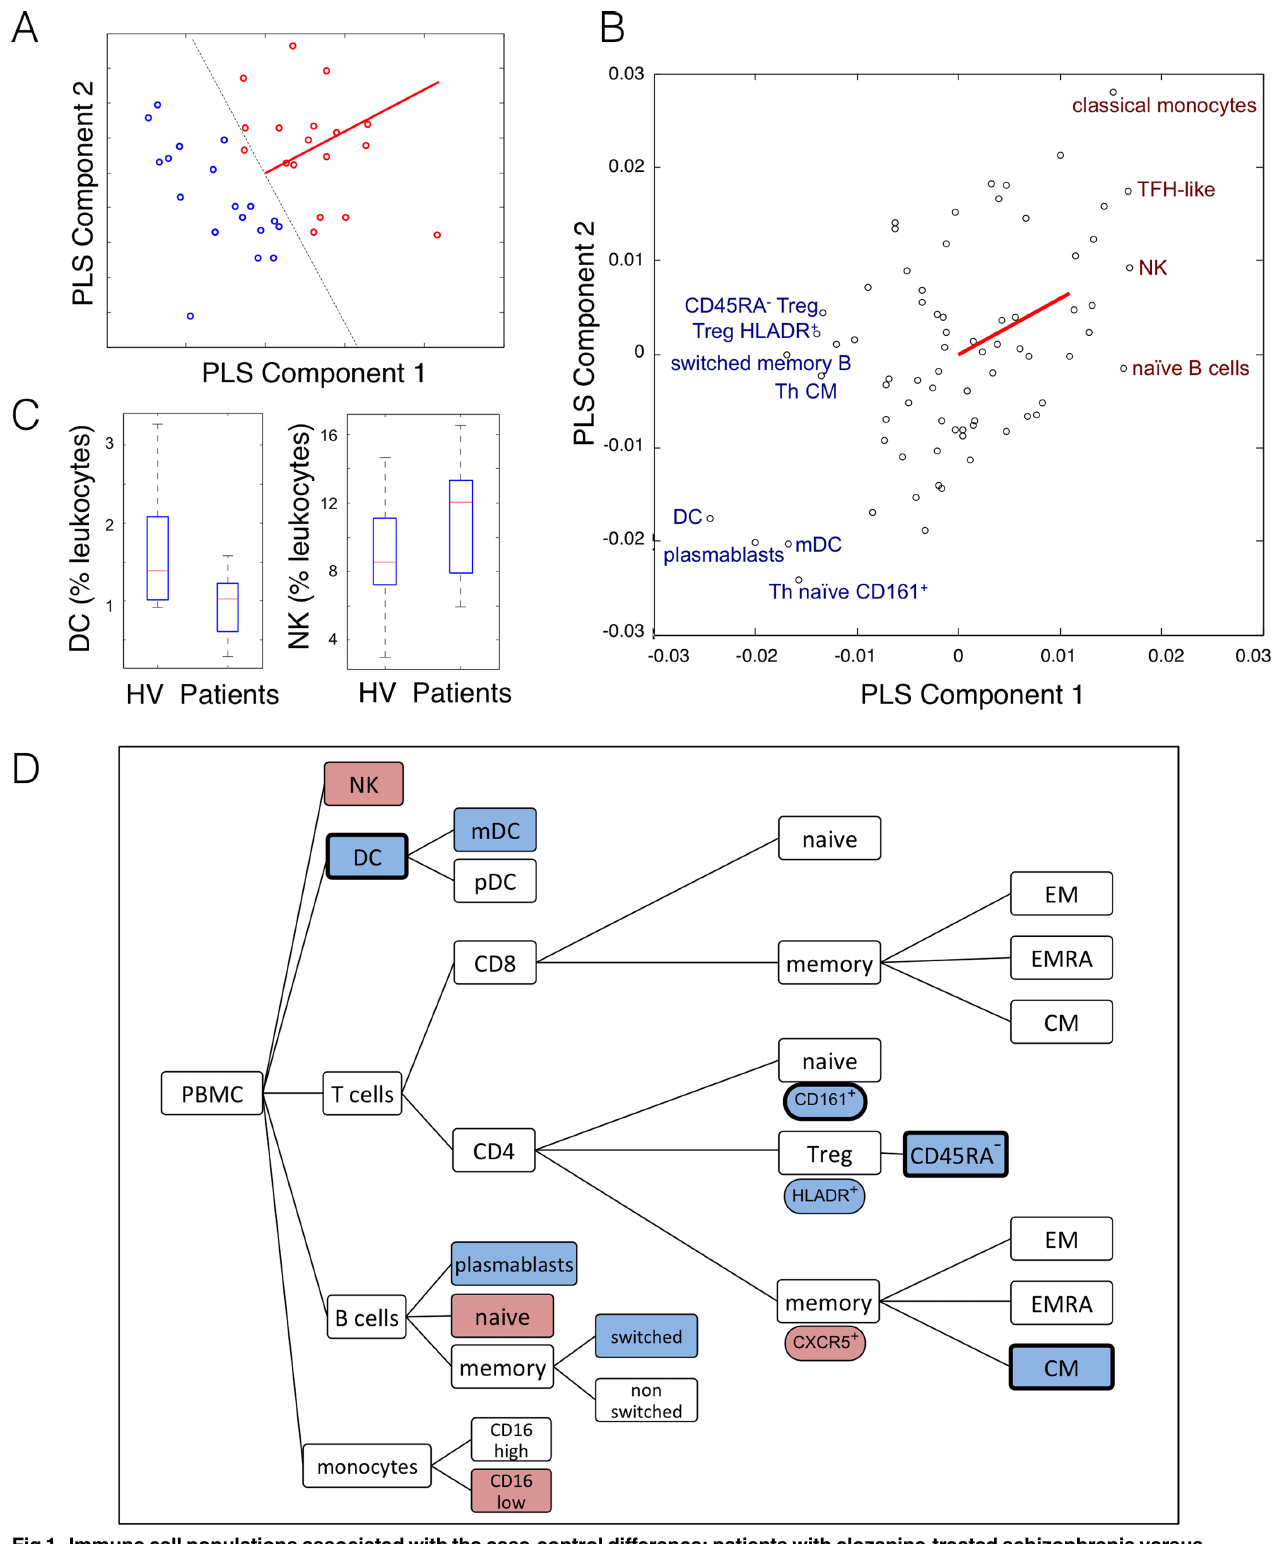
Fig 1. Immune cell populations associated with the case-control difference: patients with clozapine-treated schizophrenia versus healthy volunteers. (A) Separation of participants based on partial least squares (PLS) analysis of the diagnostic response variable: x -axis, each